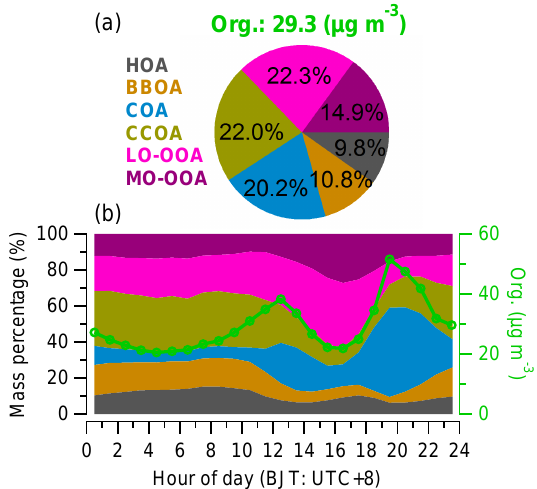
Figure 8. (a) The average mass concentration of organics and mass contributions of organic components to organics, and (b) the diurnal variations of organic components and